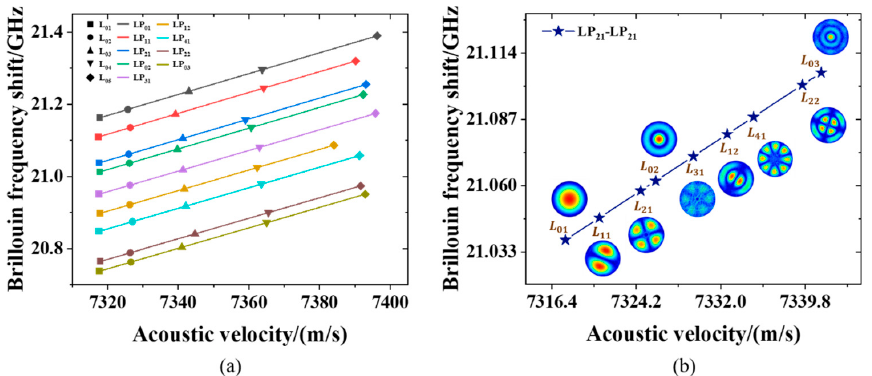
Figure 3. ( a ) The relationship between the BFS of the mode and the velocity of acoustic for the nine intramodes. ( b ) The acoustic mode profile under the LP 21 -LP 21 mode pair is shown as an inset, intramodes. ( b ) The acoustic mode profile under the LP (cid:2870)(cid:2869) - LP (cid:2870)(cid:2869) mode pair is shown as an inset, corresponding to the relationship between the velocity of acoustic and the BFS of the ten acoustic